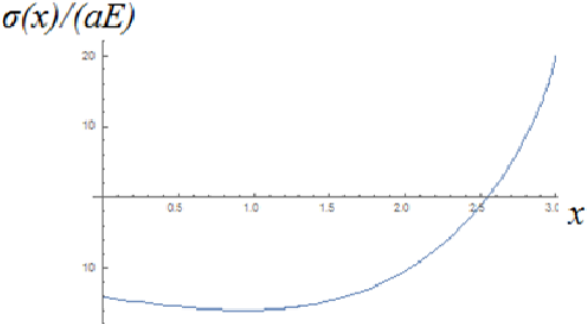
Figure 7: The distribution of stresses in the initial space with re- spect to the initial x axis